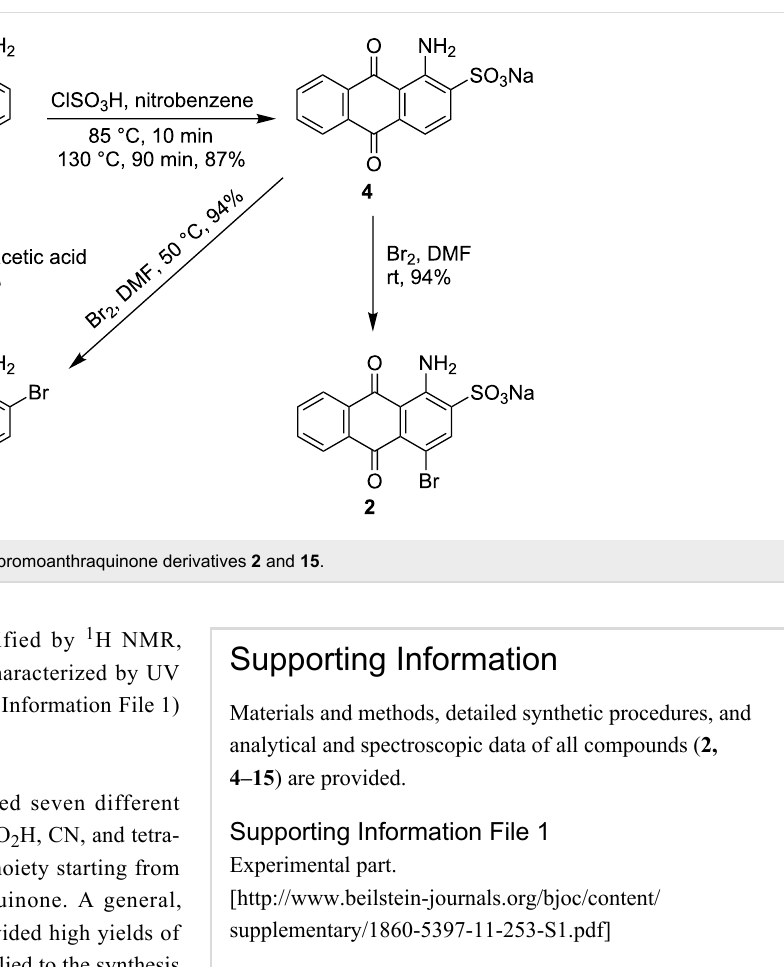
All synthesized compounds were identified by 1 H